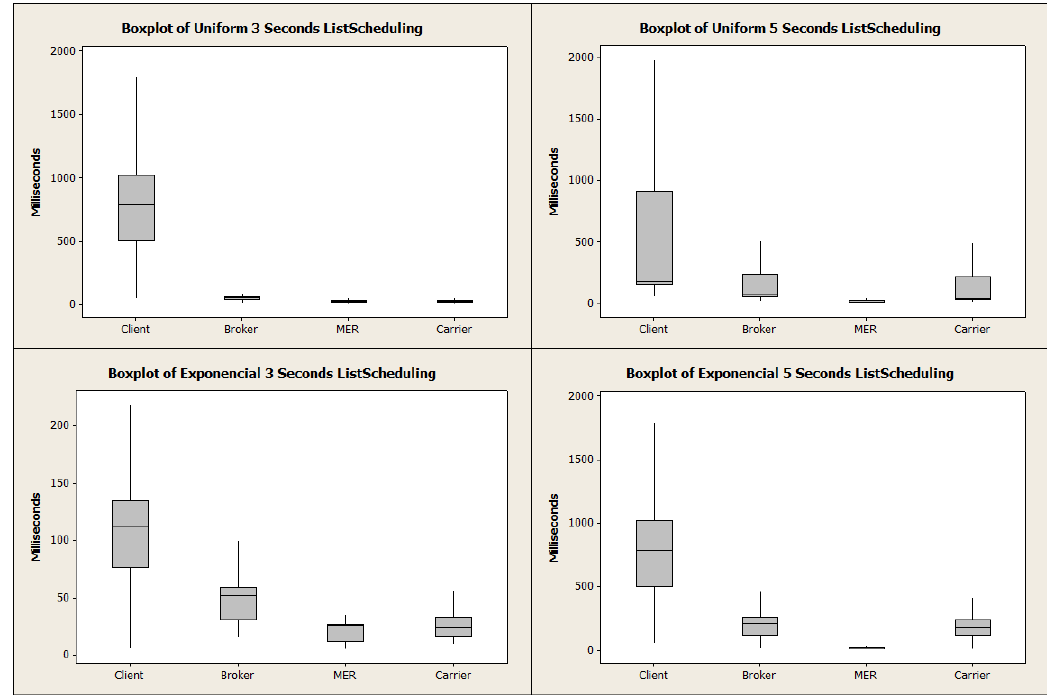
Figure 7. Average of ListScheduling time distribution.